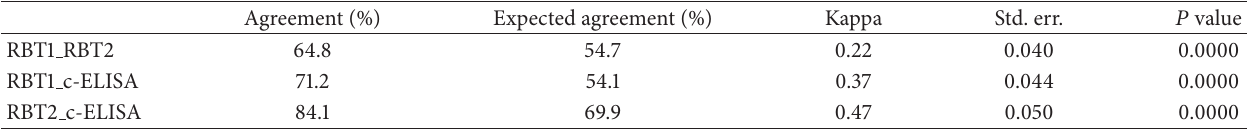
Table 5: Comparison of RBT results from two technicians and c-ELISA results ( 𝑛 =